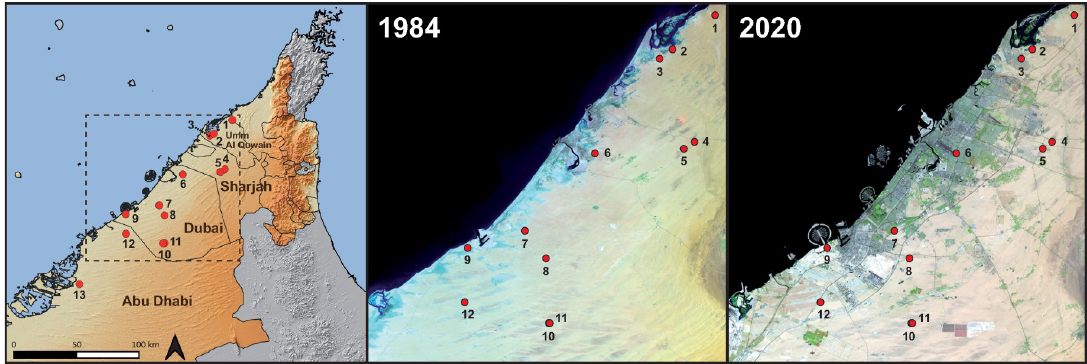
Fig 2. Localities of T . keyserlingii in the UAE used in this study. Images presenting the UAE coastline in the years 1984 and 2020 indicating the massive development in recent decades, which destroyed and fragmented the natural habitat of T . keyserlingii . Localities of specimens used in this study are indicated in red, with numbers corresponding to localities detailed in S1 Table. Localities 6, 7, 9, 12 are extinct due to urban development. Left map credits: OpenStreetMap contributors, SRTM. Middle and right images credits: Satellite images of environmental change, Earth Resources Observatory and Science (EROS) Center,